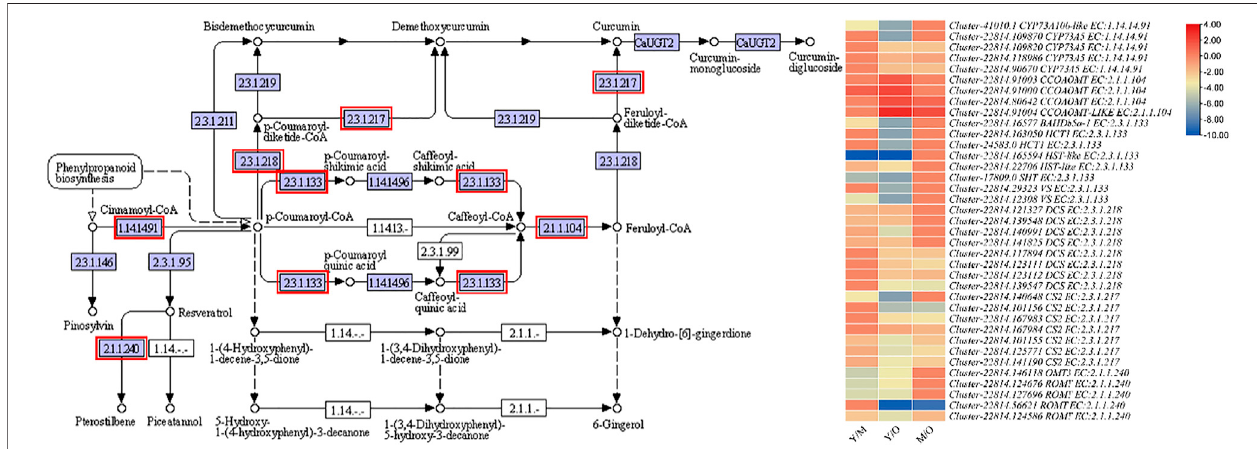
FIGURE 3 | Enrichment of DEGs in stilbenoid, diarylheptanoid and gingerol biosynthesis pathway. The heatmap shows the log2FC values of the DEGs enriched in this pathway. The genes highlighted with red boxes were differentially regulated between the three tissue types i.e., young (Y), mature (M), and old (O).